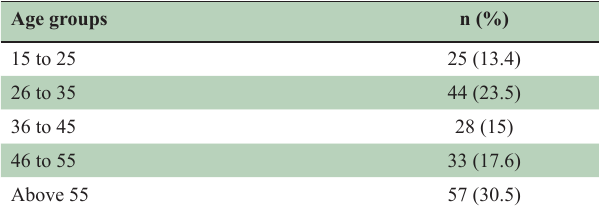
Table-II: Frequency distribution of age.